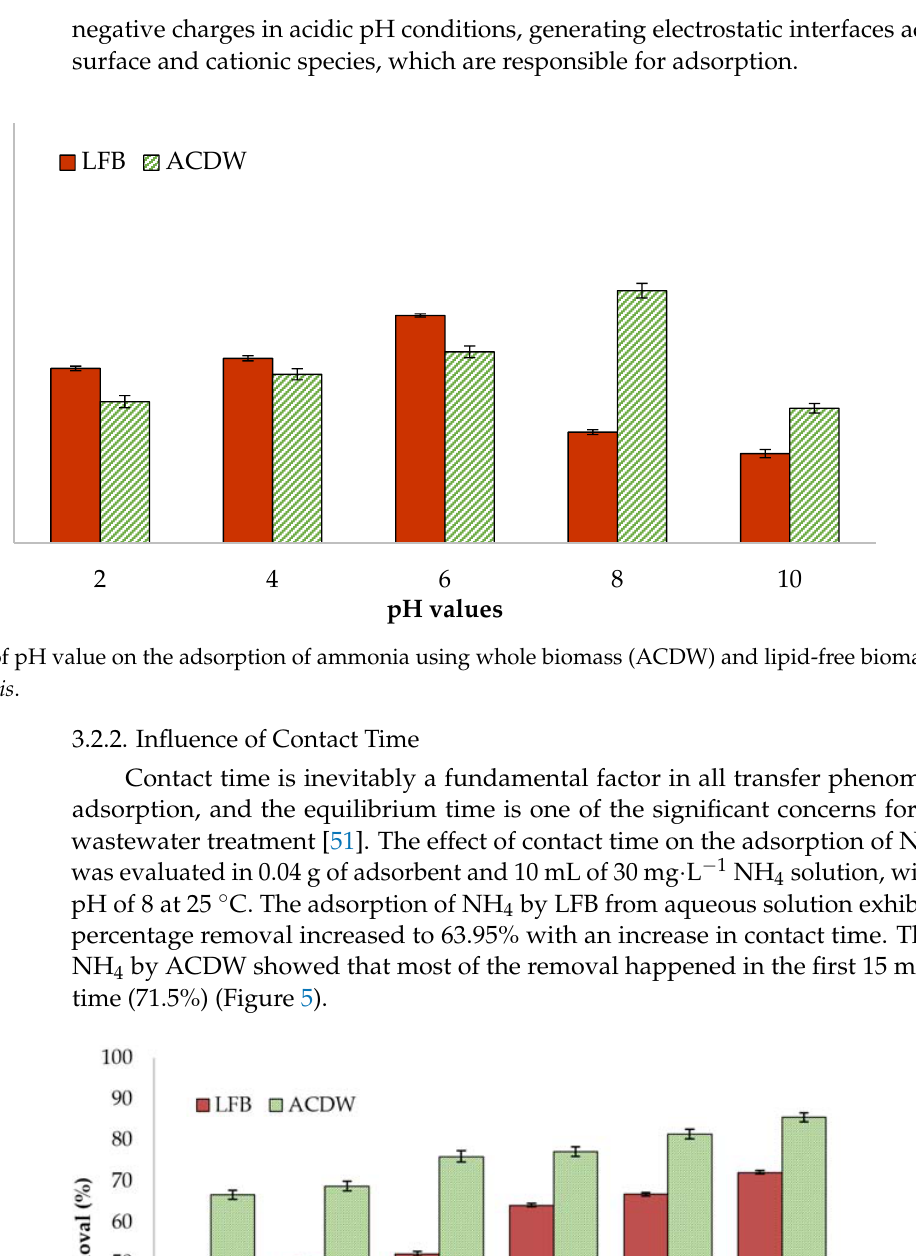
Figure 4. Influence of pH value on the adsorption of ammonia using whole biomass (ACDW) and lipid ‐ free biomass (LFB) of Arthrospira platensis .